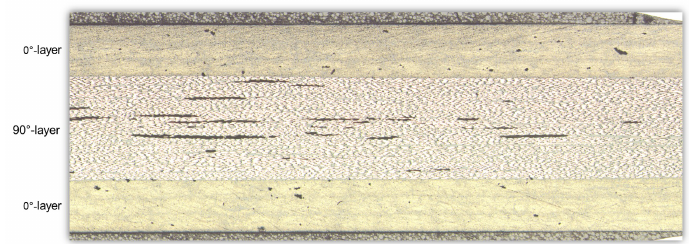
Figure 5. Full cross-section cut micrograph of the manufactured